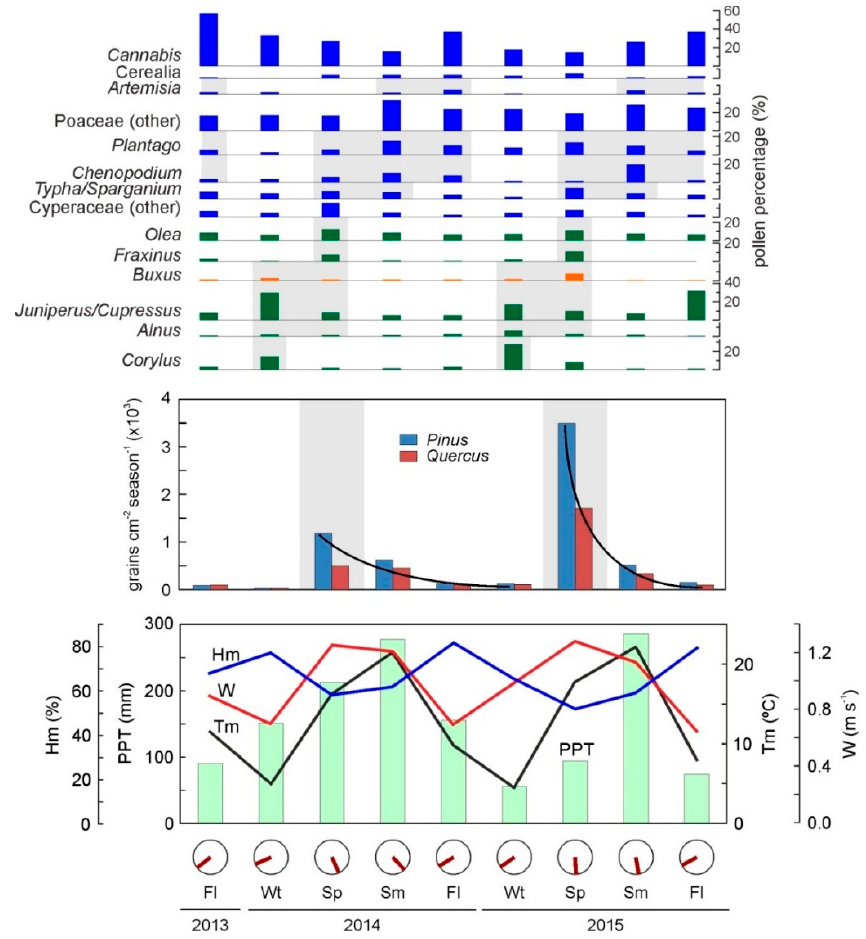
Figure 3. Summary of palynological results showing the relationship among the most relevant meteorological parameters (lower panel), the pollen influx of the superabundant pollen types (middle panel) and the percentages of selected pollen types (upper panel). Average temperature (Tm), relative humidity (Hm) and wind velocity (W) are represented by lines, total precipitation (PTT) is represented by bars. The predominant directions of the wind (Wd) are shown as circles (Sp: spring, Sm: summer, Fl: fall, Wt: winter). Pollen percentages were calculated excluding the abundant Pinus and Quercus . Taxa are ordered by their respective flowering seasons (grey bands) from bottom to top and from left to right. The flowering season of all species of the different genera present in the Montcortès region [40] has been considered. Trees are shown in green, shrubs are in orange and herbs are in blue. Cultivated plants, such as Cerealia, Cannabis and families including many genera (Poaceae, Cyperaceae), are located based on their pollen patterns due to the difficulty of establishing a definite flowering season. Redrawn and modified form [19].